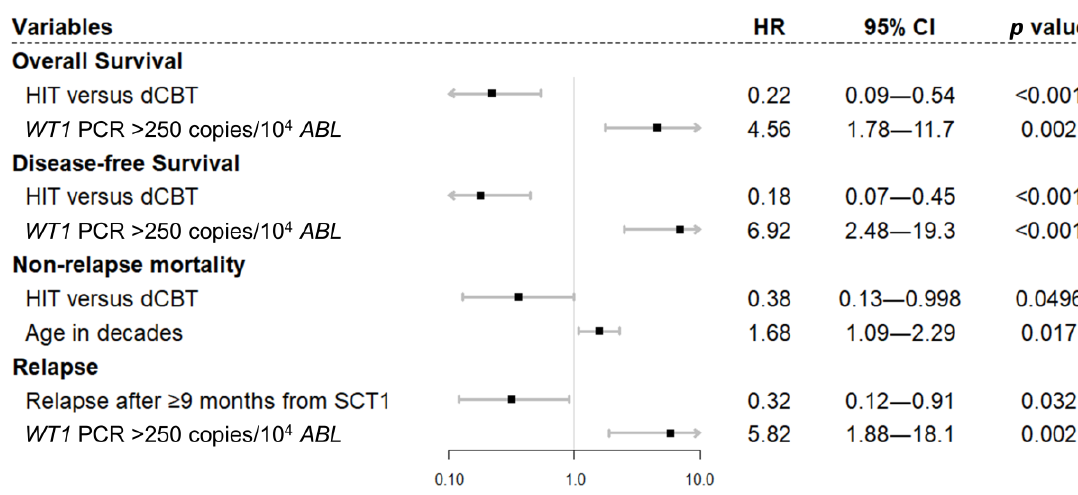
Figure 3. Multivariate analysis of outcomes after second transplantation for patients with available pre-transplant WT1 -PCR ( N = 38).